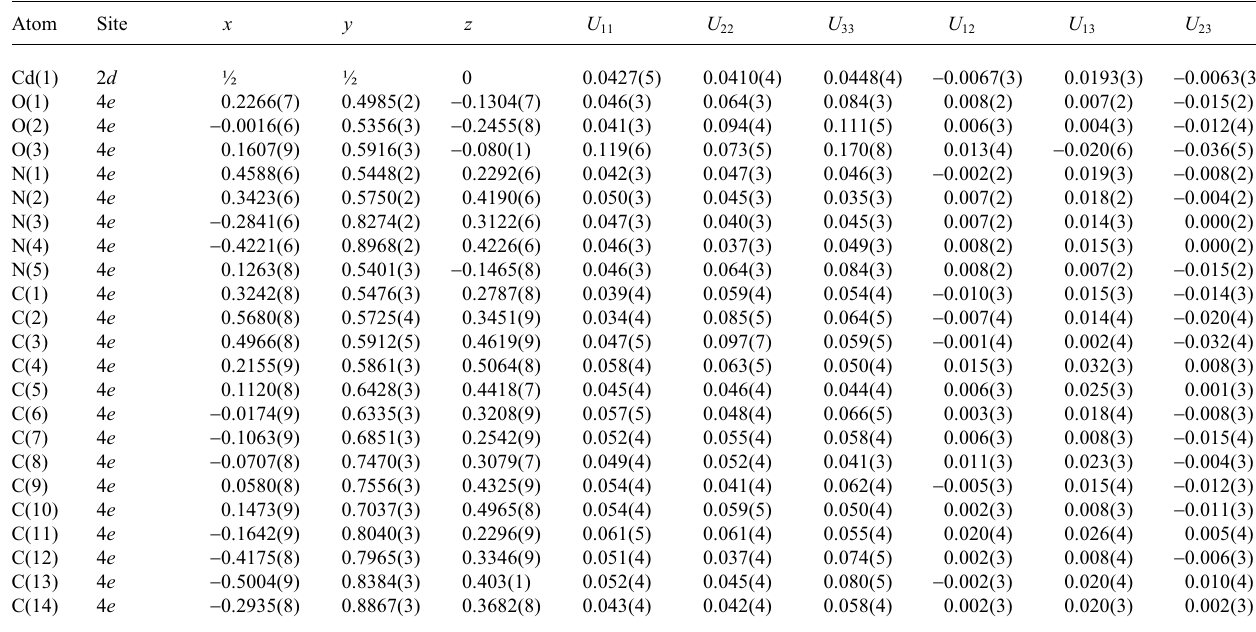
Table 3. Atomic coordinates and displacement parameters (in Å 2 ).